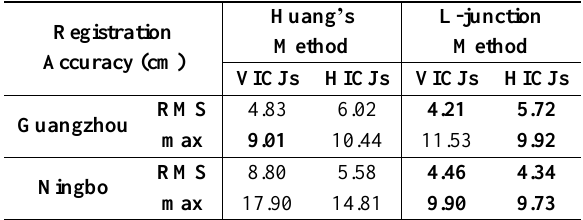
Table 4. The registration accuracy.